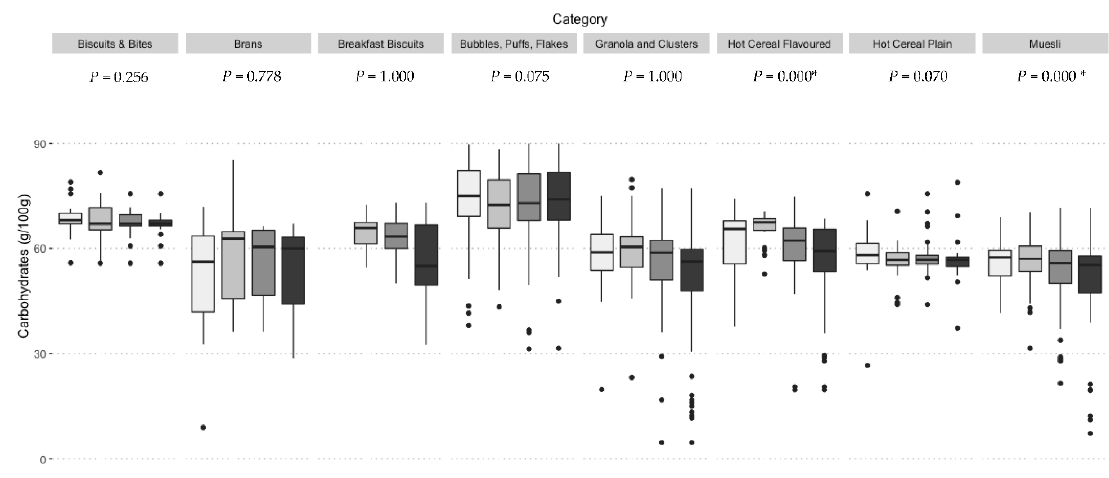
Figure A3. Sugars content of breakfast cereals (g/100 g) between 2013, 2015, 2018, and 2020; p value comparing 2013 vs. 2020 (2015 vs. 2020 for breakfast biscuits). * Statistically significant p < 0.05.